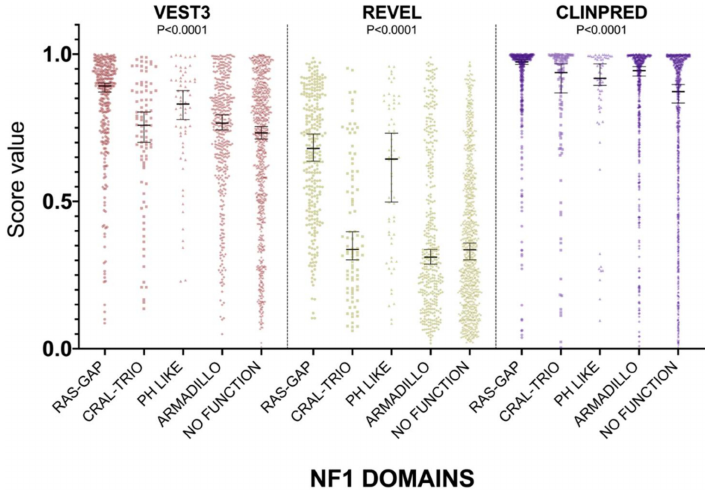
Figure 3. Prediction score values in the principal NF1 functional domains annotated at InterPRO (RAS-GTPase aa 1210–1549; CRAL-TRIO LIPID BINDING DOMAIN aa 1581–1726; PH-LIKE Pleckstrin homology domain aa 1727–1837; Armadillo type fold aa 1849–2676; NO FUNCTION all amino acid not comprised in the previous domains). Medians with 95% confidence intervals are reported. The P value of non-parametric ANOVA is reported for each predictor (Kruskal-Wallis